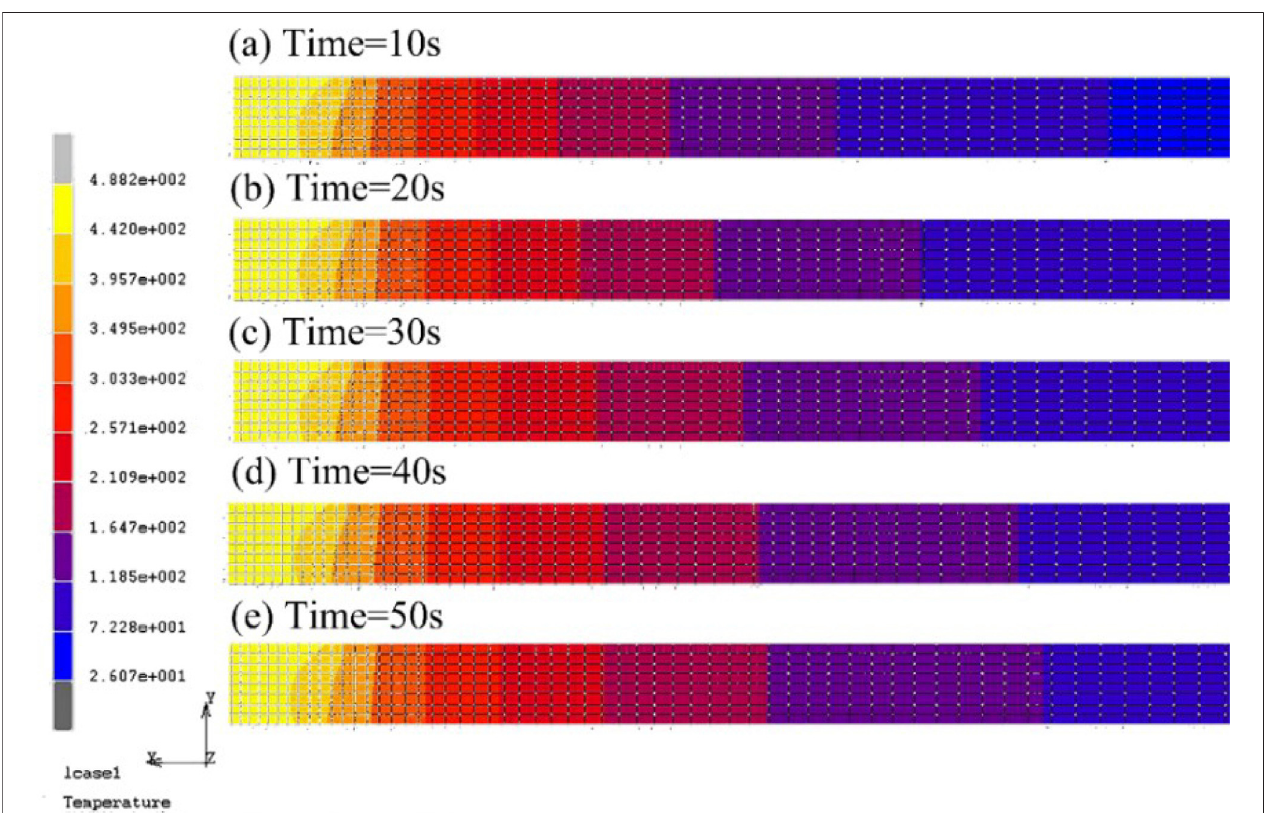
FIGURE 6 | Contour of temperature distribution at different time in the transverse section of the workpiece (unit: ° C): (a) 10 s, (b) 20 s, (c) 30 s, (d) 40 s, (e) 50 s.